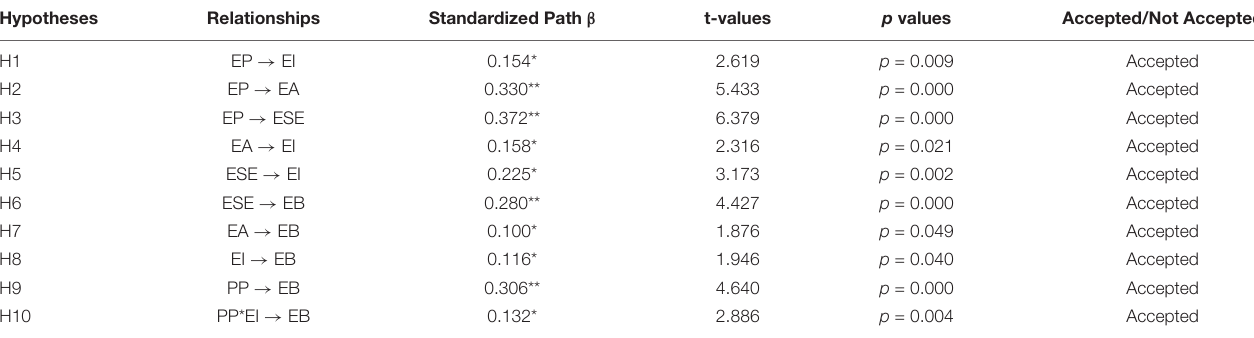
TABLE 4 | Path analysis (direct